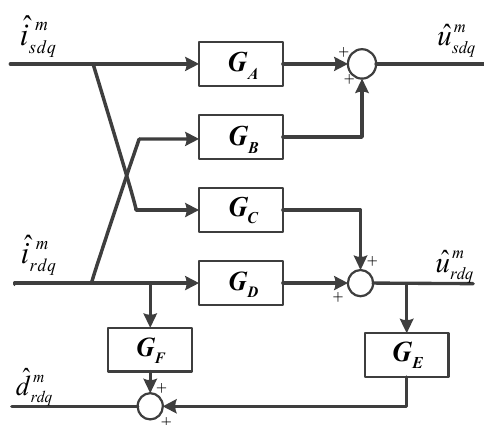
Figure 4. The structure diagram of the RSC main circuit.